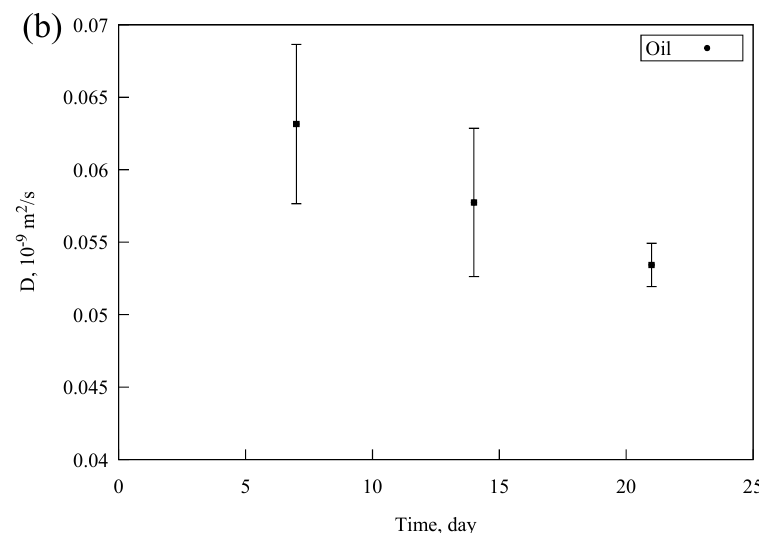
Figure 12. Diffusion coefficient for rock saturated with different fluids 25 ◦ C. ( a ) 1% Na 2 SO 4 and 100% Na 2 SO 4 for 21 days; ( b ) Crude oil for 21